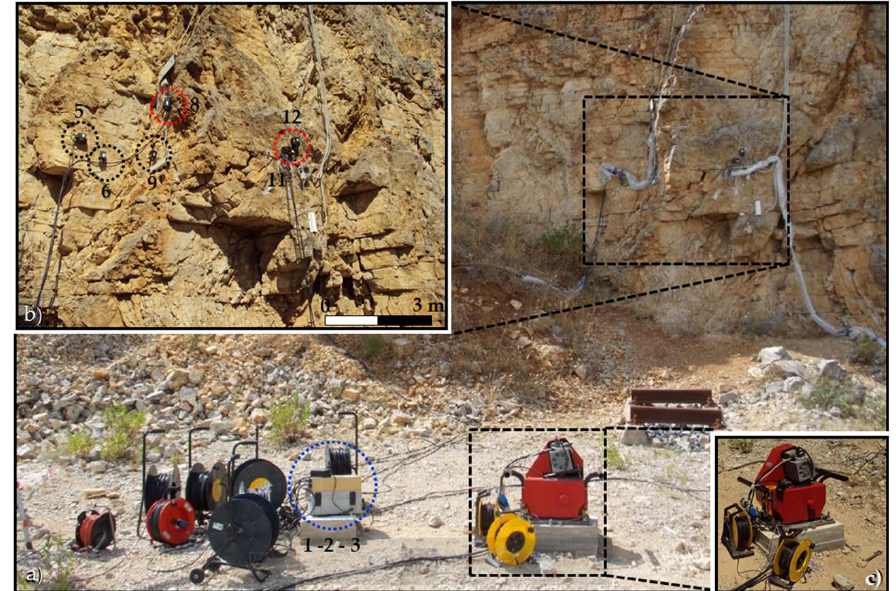
Figure 2. Devices installed at the Acuto test-site for the dynamic excitation experiments. The rock block is highlighted ( b ) with the disposition of the mono-axial accelerometers on the rock wall (black dashed circles) and on the rock block (red dashed circles). The mono-axial accelerometers installed on the ground (blue dashed circles) are shown in the main picture ( a ) with the vibrodyne device ( c ) .